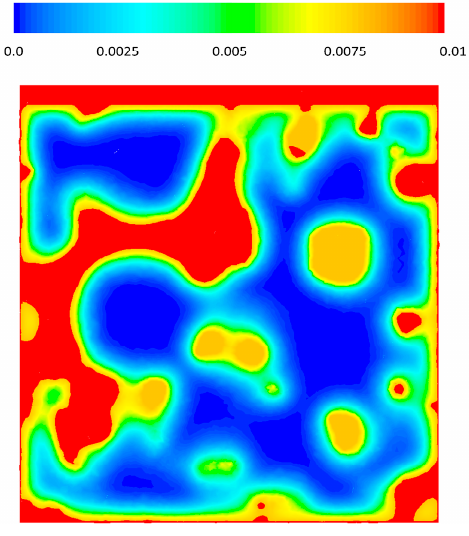
Figure 8. CO mass fraction on a cross sectional plane, x = 0.